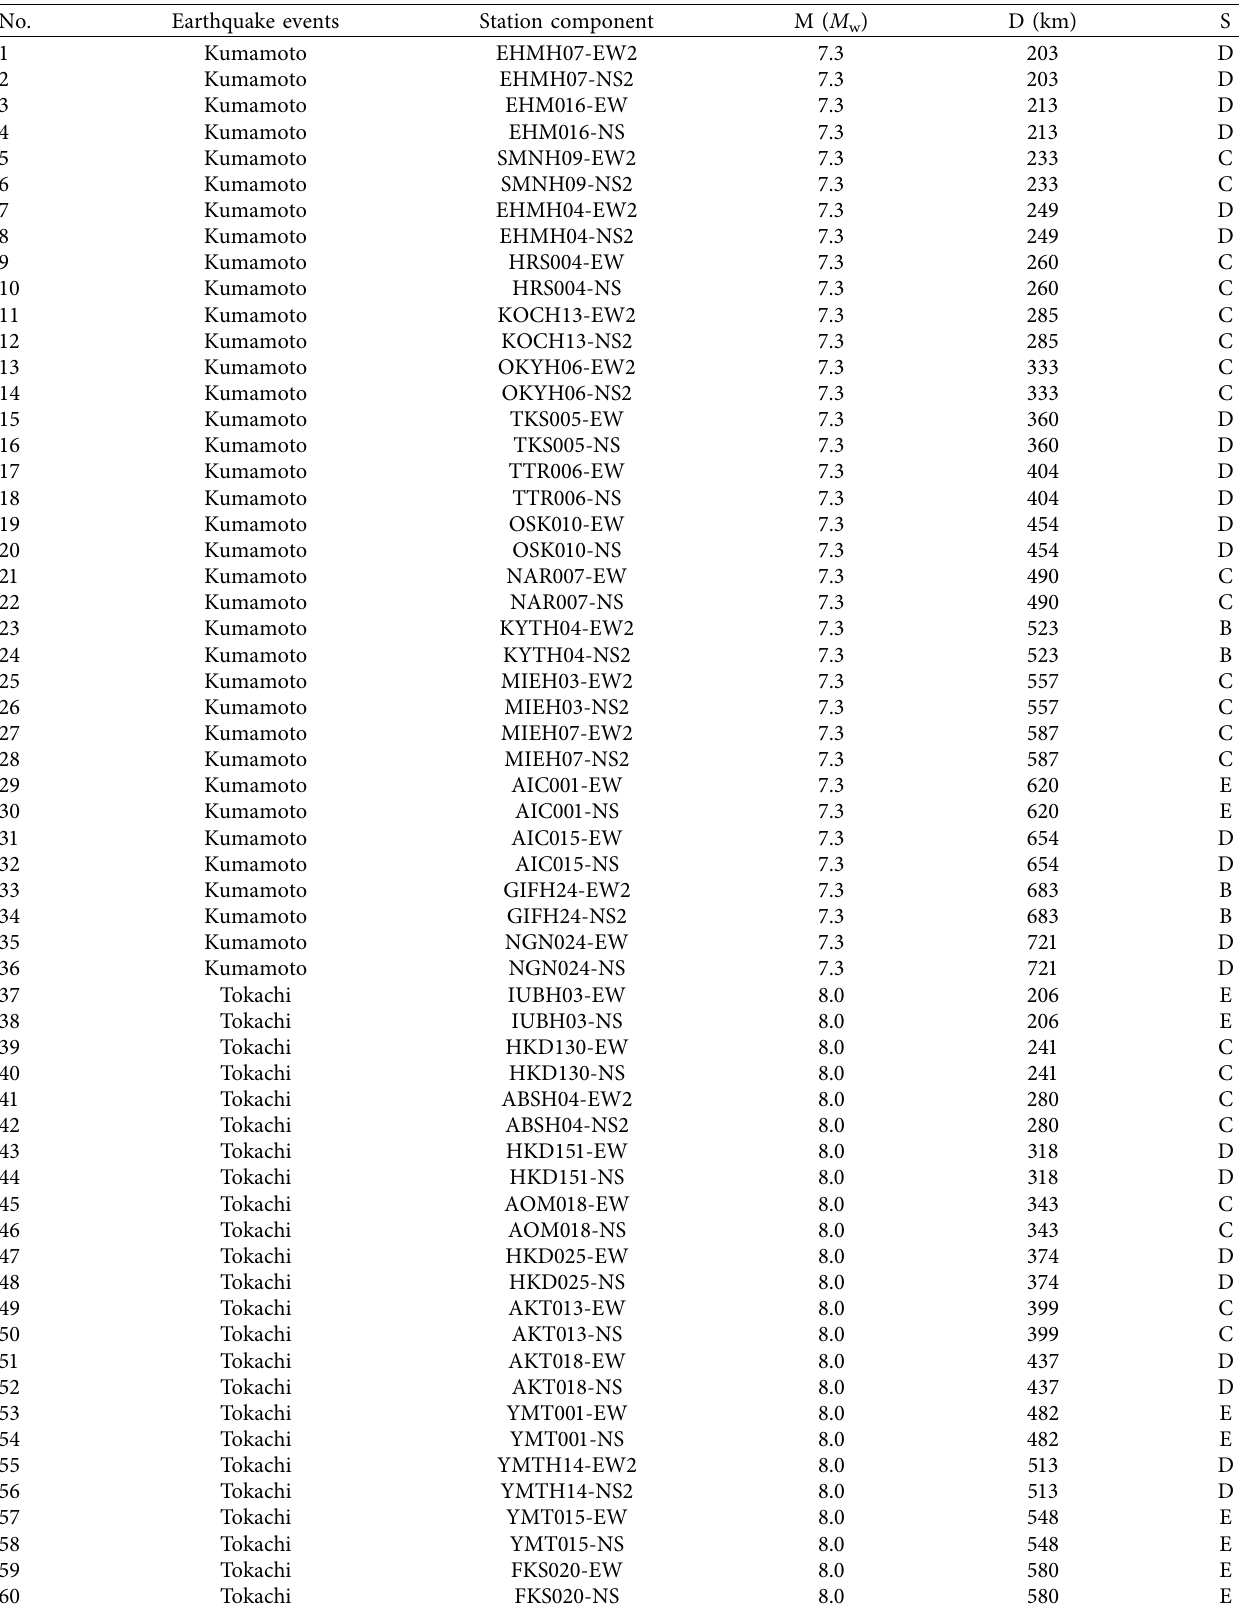
Table 2: Basic information of far-field harmonic earthquake